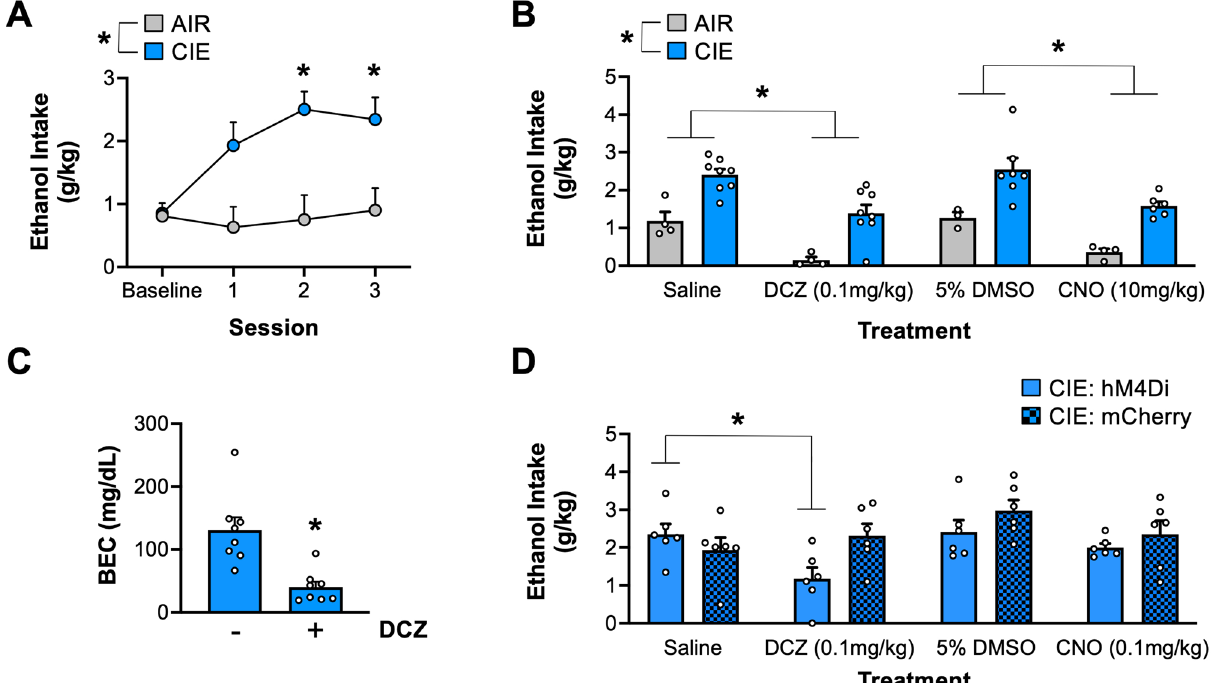
Figure 3. DCZ-mediated chemogenetic inhibition of the central amygdala reduces dependence ethanol drinking. ( A ) Average 2 h ethanol intake in AIR- and CIE-exposed rats during baseline drinking and 3 sessions of 2BC drinking in the withdrawal drinking phase following CIE exposure. CIE-exposed rats exhibited escalated ethanol intake beginning in session 2, relative to their baseline, and consumed more than AIR controls overall. ( B ) Average 2 h ethanol intake in AIR- and CIE-exposed rats during drug treatment test sessions. CIE-exposed rats continued to exhibit elevated ethanol intake, relative to AIR controls. Further, DCZ (0.1 mg/kg) and CNO